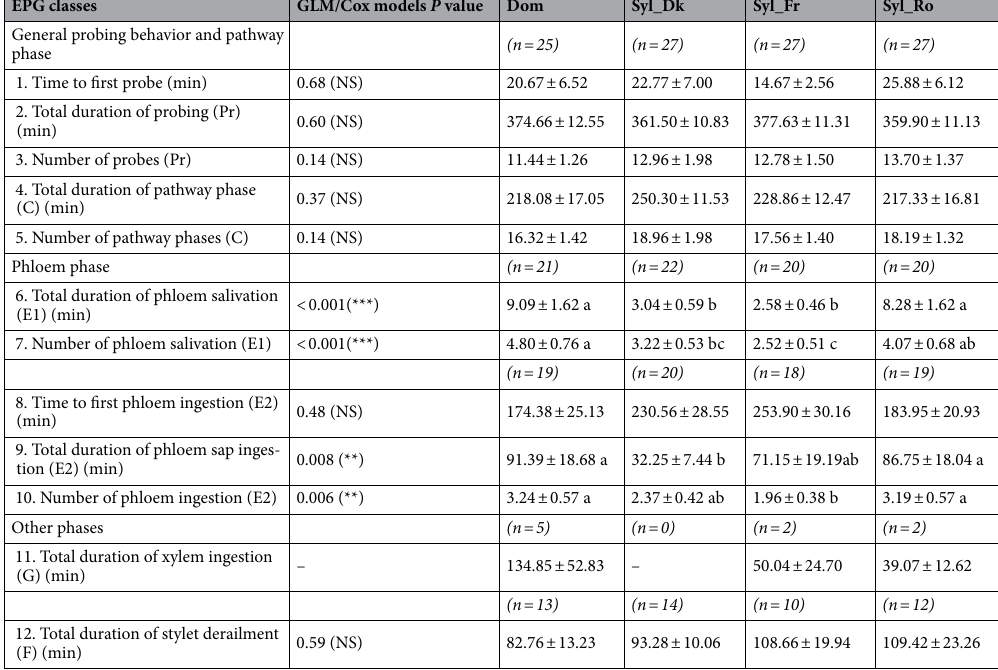
Table 1. Feeding phases (mean ± standard error of the mean) of Dysaphis plantaginea feeding on plants belonging to the three Malus sylvestris populations (i.e., Danish, French and Romanian, hereafter referred to as “Syl_Dk”, “Syl_Fr”, “Syl_Ro”, respectively) and to the Malus domestica genepool (“Dom”). The letters within a row indicate significant differences associated with pairwise comparisons using estimated marginal means. * P < 0.05; ** P < 0.01; *** P < 0.001 associated with GLM models (using respectively Poisson and Gamma distribution for the number and total duration of feeding phases) or Cox models (for “time to first phase”) (degree of freedom = 3 for each